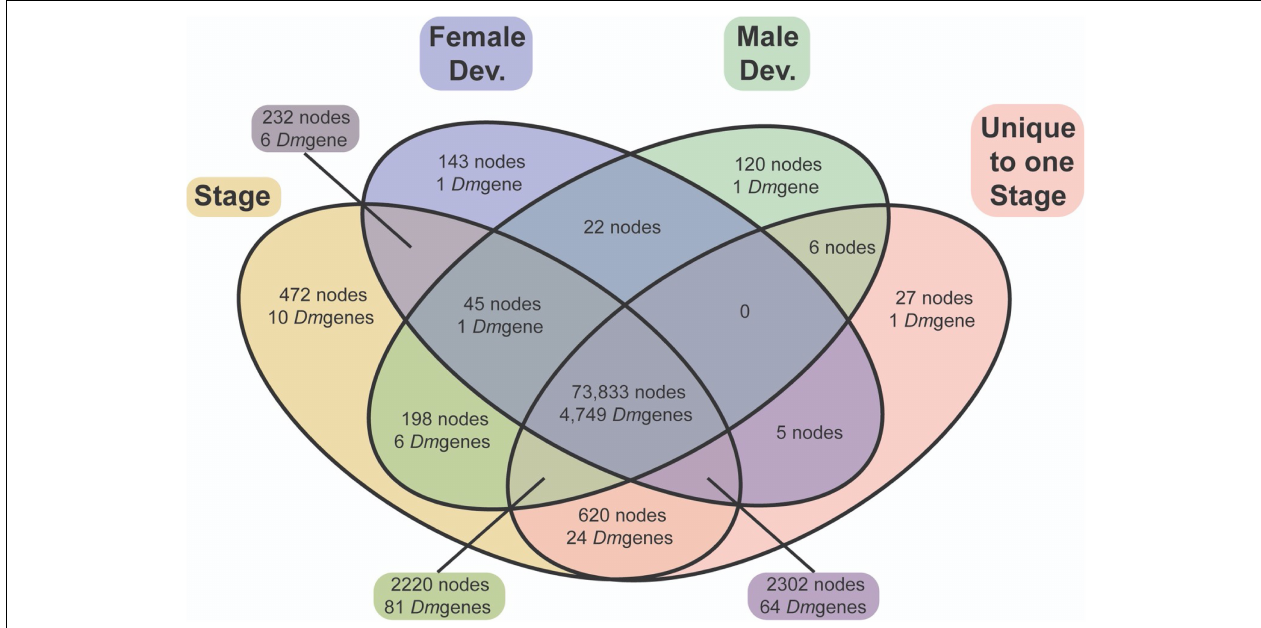
FIGURE 8 | A Venn diagram of differential expression of nodes and genes annotated with similarity to Drosophila genes. Most DEN (73,900) exhibit differential expression throughout development within both males (green) and females (blue). A similar number of nodes are expressed in a sex-specific manner throughout development in both males and